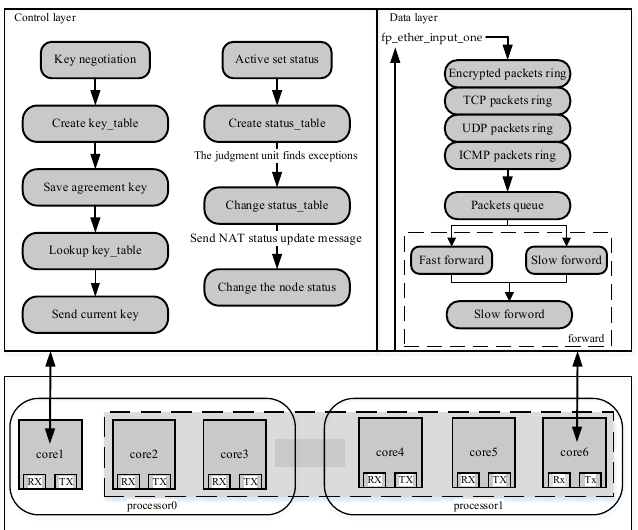
Figure 5. Multicore and multichannel MVPN optimization design process.